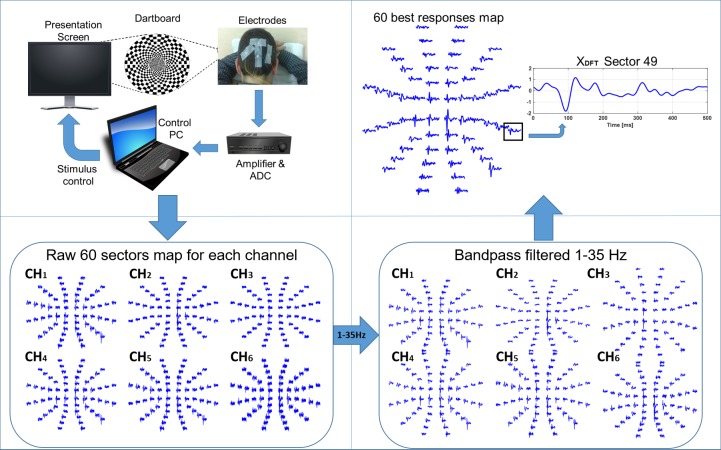
Typical mfVEP analysis method.Upper left: stimulus and recording process; lower left: 60-sector signal map for each of the six channels; lower right: 60-sector signal map for each of the six channels after 1–35Hz bandpass filtering; upper right: 60-sector signal map for the best channel of each sector and signal for one sector.